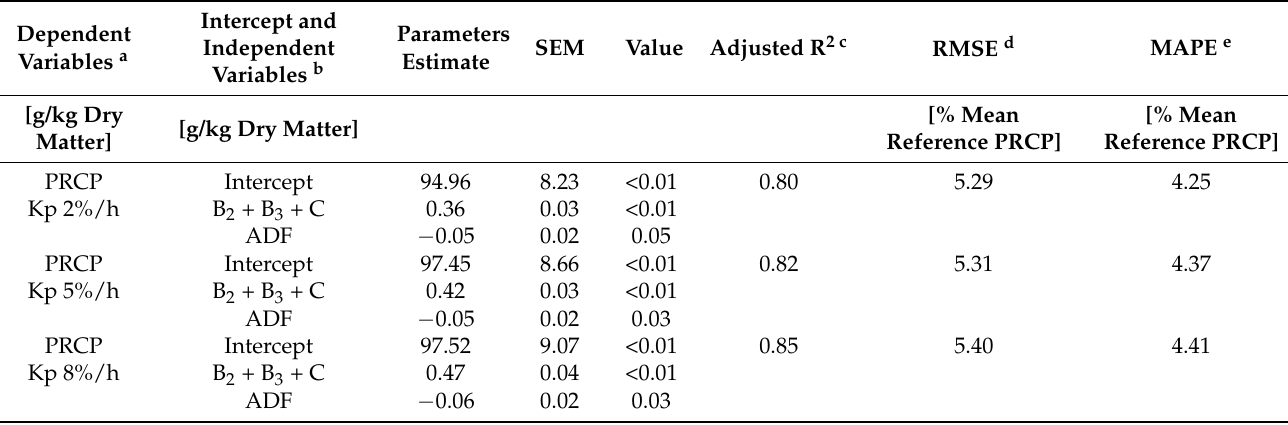
Table 3. Statistical parameters of multivariate regression models developed to estimate post-ruminal crude protein (PRCP) supply at rumen passage rates of 2, 5, and 8%/h of fresh tropical forage grasses and legumes (n =